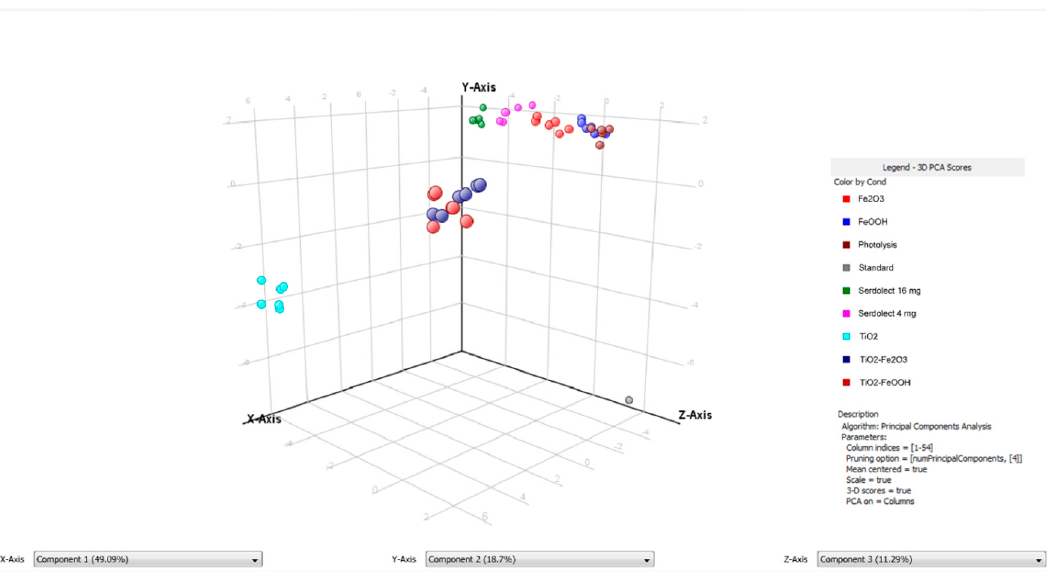
Figure 8. 3D principal component analysis (PCA) plot of irradiated and non-irradiated sertindole